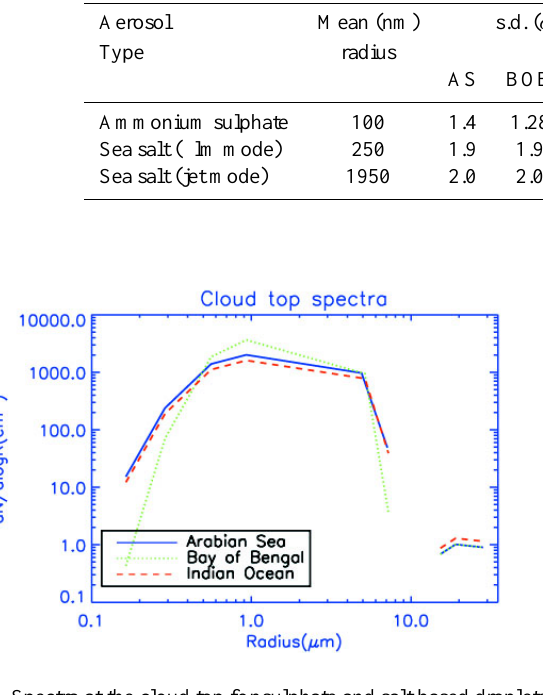
Fig. 2. Spectra at the cloud top for sulphate and salt based droplets for the three regions.